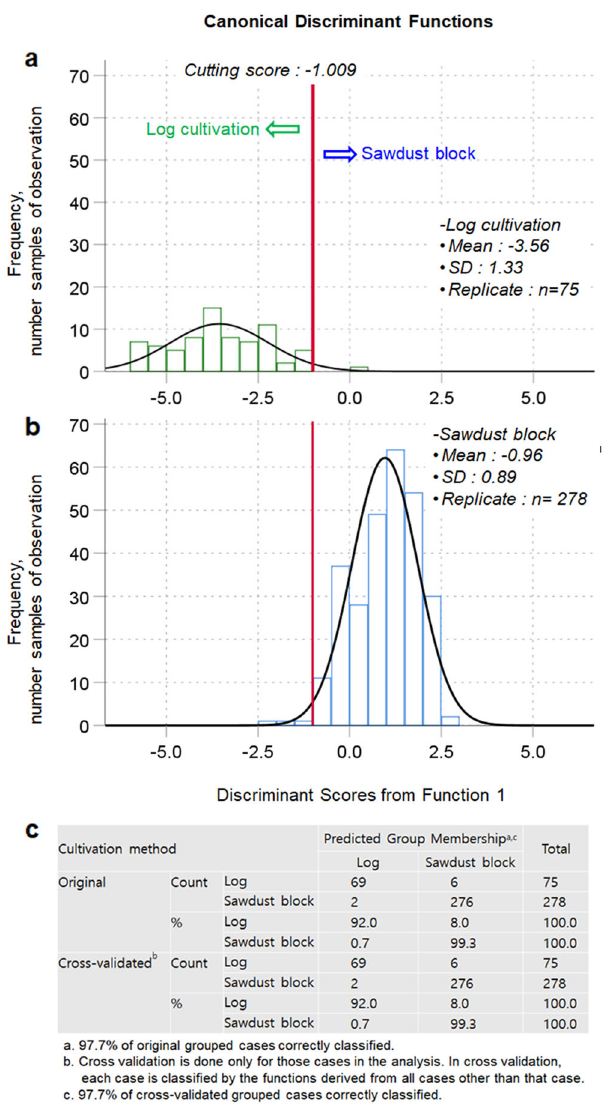
Fig. 2 Discriminant analysis of shiitake mushroom depending on the cultivation method. a Discriminant scores of log cultivation, b Discriminant scores of sawdust block cultivation, and c Classi fi ca- tion and cross-validated results of the shiitake cultivation